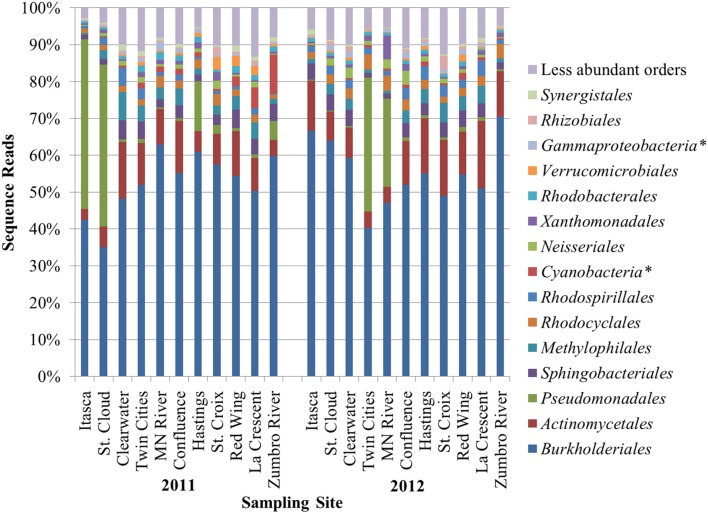
Distribution of the most abundant orders identified at sampling sites among triplicate samples at each site. Asterisks (*) denote orders designated incertae sedis.